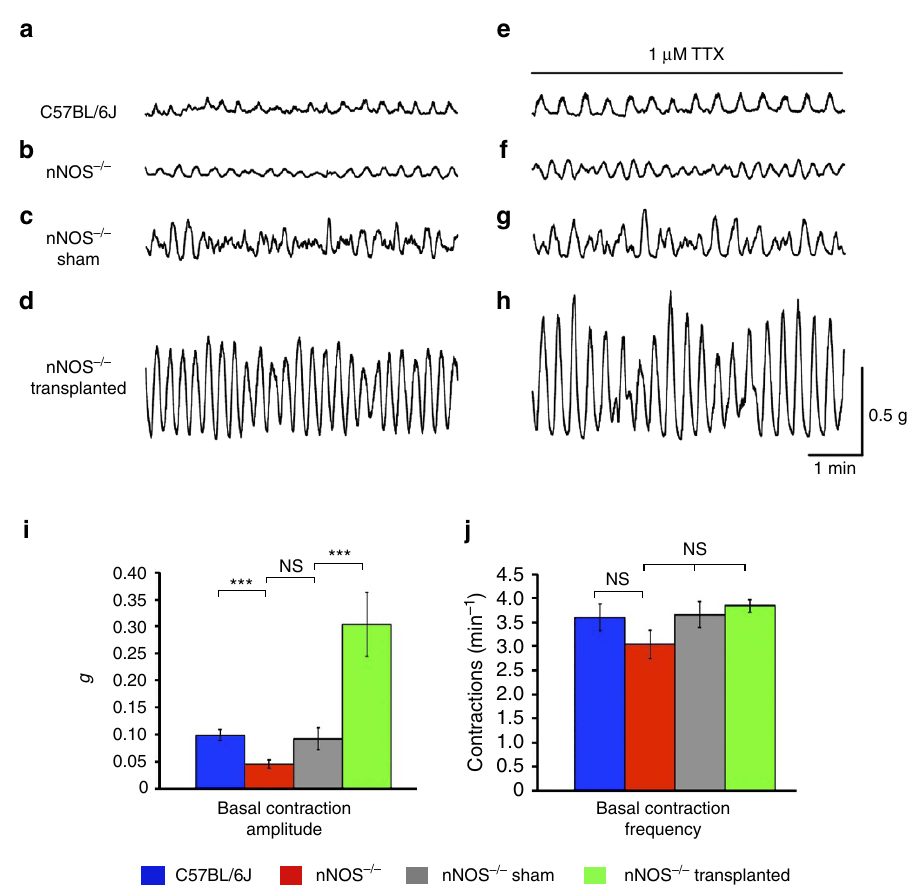
Figure 4 | ENSC transplantation alters basal contractile patterns in nNOS (cid:2) / (cid:2) distal colon. ( a – d ) Representative organ bath contractility traces demonstrating basal contractile properties of C57BL/6J, nNOS (cid:2) / (cid:2) , sham-operated nNOS (cid:2) / (cid:2) and transplanted nNOS (cid:2) / (cid:2) distal colon in control conditions. ( e – h ) Representative organ bath contractility traces demonstrating basal contractile properties of C57BL/6J, nNOS (cid:2) / (cid:2) , sham-operated nNOS (cid:2) / (cid:2) and transplanted nNOS (cid:2) / (cid:2) distal colon from a – d after the addition of TTX. ( i ) Quantification of basal contractile amplitude in C57BL/6J (blue bars), nNOS (cid:2) / (cid:2) (red bars), sham-operated nNOS (cid:2) / (cid:2) (grey bars) and transplanted nNOS (cid:2) / (cid:2) (green bars) distal colon. n ¼ 5 for each group. *** P r 0.001 by Student’s t -test. ( j ) Quantification of basal contractile frequency in C57BL/6J (blue bars), nNOS (cid:2) / (cid:2) (red bars), sham-operated nNOS (cid:2) / (cid:2) (grey bars) and transplanted nNOS (cid:2) / (cid:2) (green bars) distal colon. n ¼ 5 for each group. Error bars represent mean ± s.e.m. in all